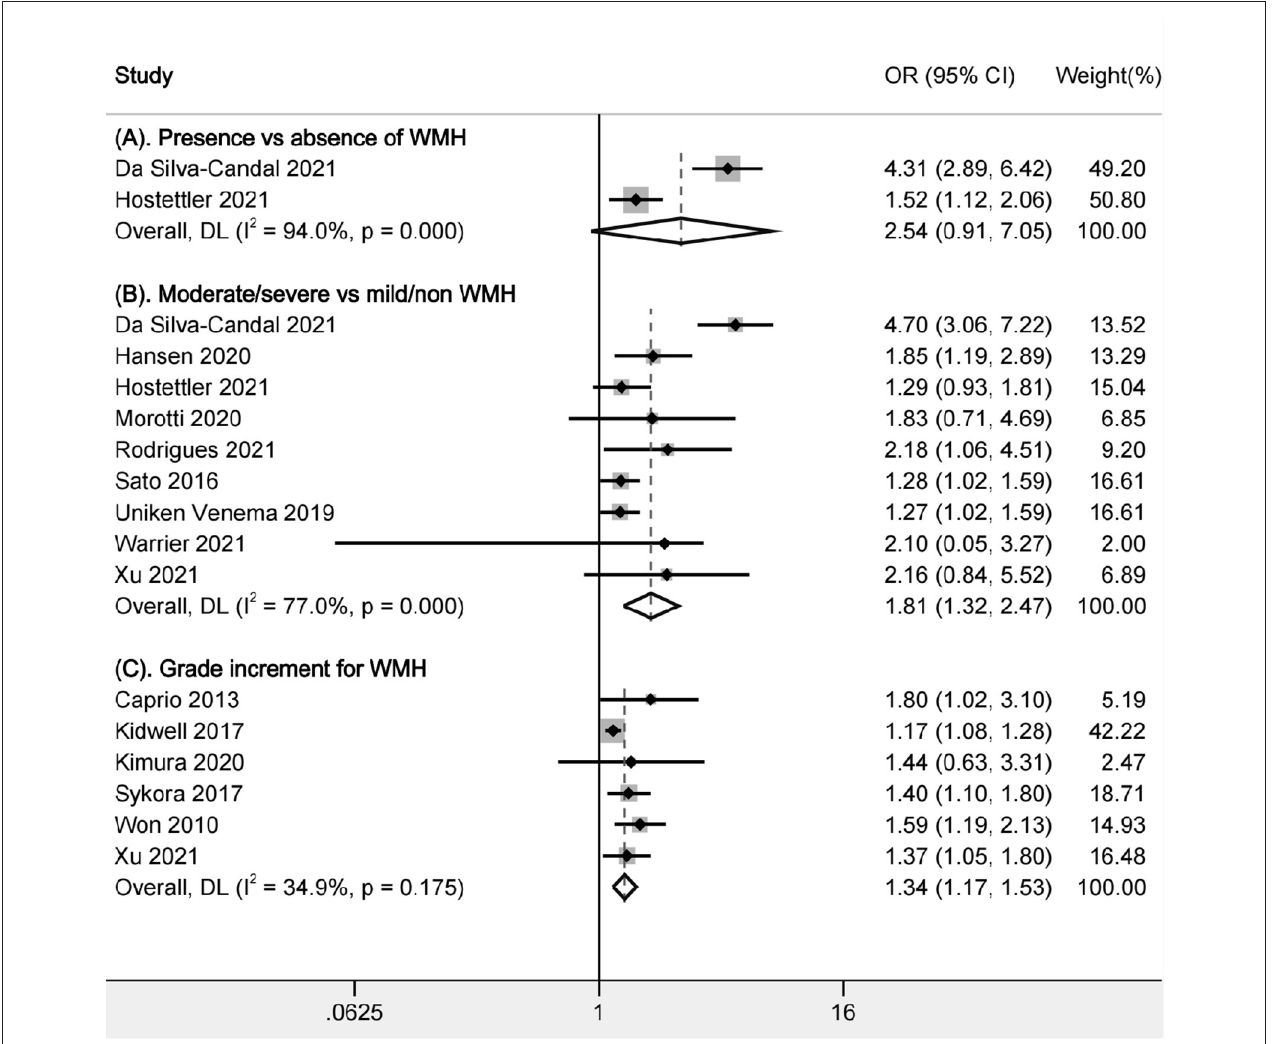
FIGURE 2 | Pooled analysis of relationship between WMH and poor functional outcome. (A) Comparison between presence and absence of WMH; (B) Comparison of functional outcomes between moderate/severe and none/mild WMH; (C) Ordinal increase in a WMH grade. WMH: white matter